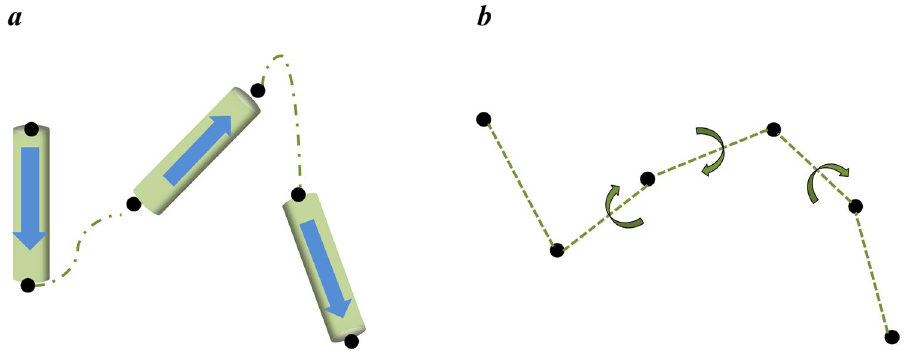
Figure 1. Schematic of the joint-based approach for macroscopic description of the protein structure. ( a ) Secondary structure-based description of the protein structure. The arrow means the sequence of amino acids of the protein with increasing residue numbers. ( b ) Newly devised joint-based description of the protein structure using the joints of secondary structures and their dihedral angles.